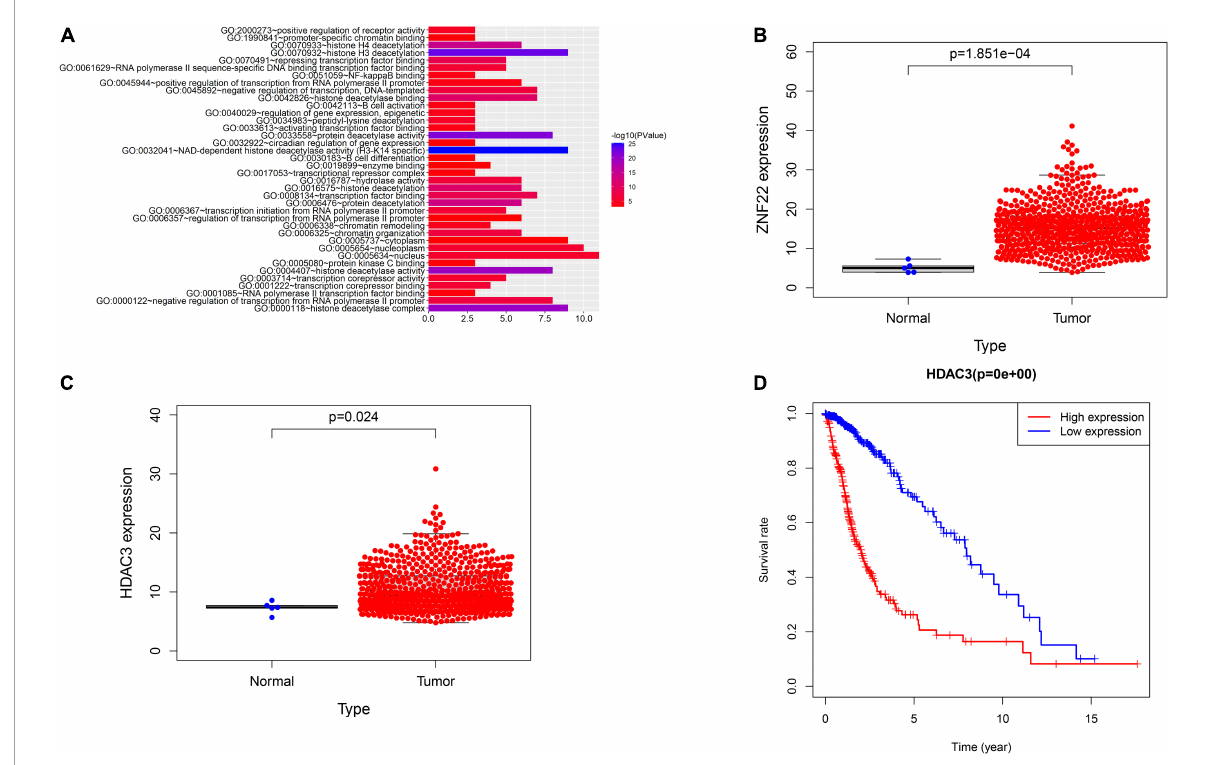
FIGURE1 Analysis using bioinformatics. (A) GO analysis of HDAC family and ZNF22. (B) GDC database-based study of the relative expression of ZNF22 in gliomas. (C) GDC database-based study of the relative expression of HDAC3 in gliomas. (D) Survival curves of glioma patients with high HDAC3 expression based on the GDC